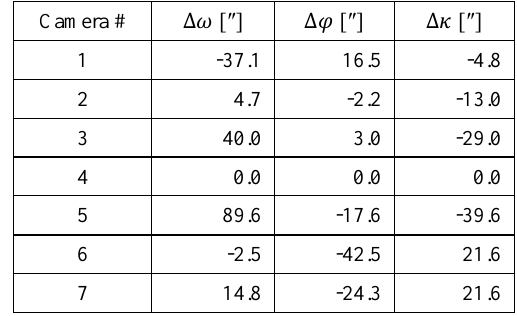
Table 8. Differences in the rotational components of the ROPs between the three-round minor calibration and the full major calibration